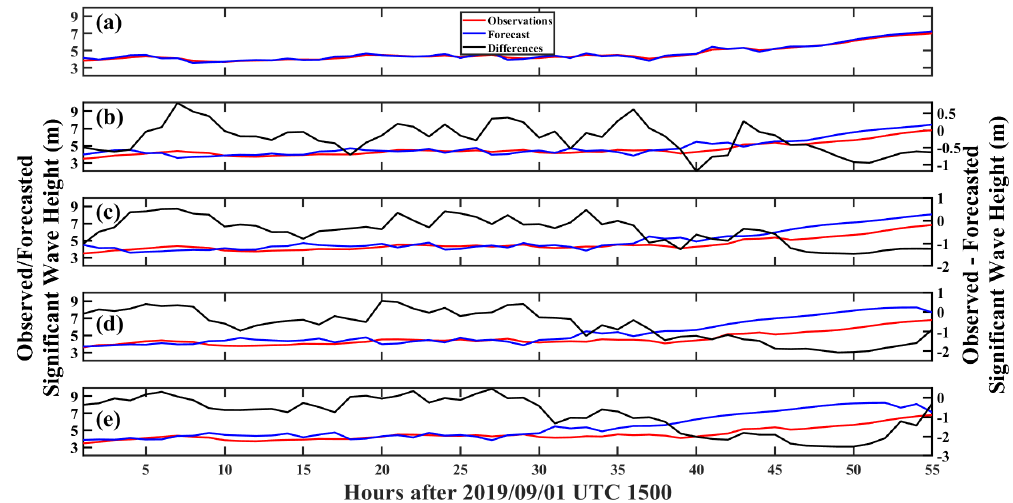
Figure 3. Time series of Hurricane Dorian observed and LSTM-forecasted SWH (m) at the (a) 0, (b) 3, (c) 6, (d) 9, and (e) 12h horizons measured at buoy 41010.